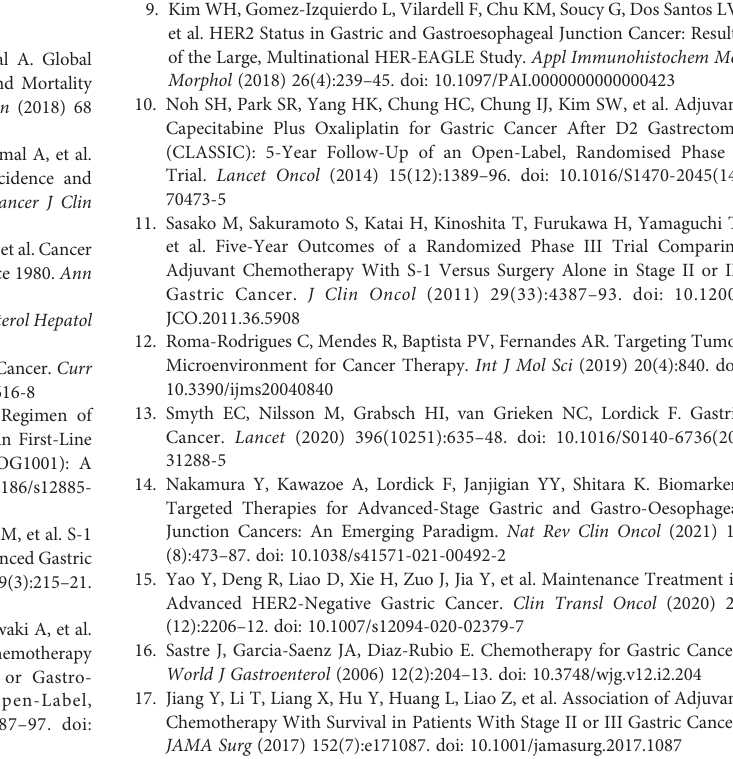
Supplementary Figure 1 | Data quality evaluation. (A) Box plot of protein identi fi cationnumbersin fi vehospitals. (B) PCAof833samplesin fi vehospitals. (C) Violin plotofproteinidenti fi cationnumbersinthreedatasets. (D) Boxplotofproteinabundance in each sample in three datasets. Supplementary Figure 2 | The clustering result and differentially expressed proteins of the molecular subtypes in discovery set. (A) The silhouette plot of clustering results obtained from AE. (B) Volcano plot of differentially expressed proteins in two subtypes. Supplementary Figure 3 | Classi fi ers were established to predict survival-risk labels for samples in independent set. (A) A heat map based on the 56 selected proteins expression. (B, C) The ROC curve of LR and SVM on training set with 10- fold CV, respectively. (D – F) The OS by chemotherapy status for S-II predict by RF, LR, and SVM, respectively. Supplementary Figure 4 | The clustering results obtained from two alternative approaches in discovery set. (A) The silhouette plot of clustering results and (B) the OS by chemotherapy status for S-II obtained from PCA. (C) The silhouette plot of clustering results and (D) the OS by chemotherapy status for S-II obtained from UMAP. Supplementary Figure 5 | The clustering results obtained by the protein features transformed from AE in the external validation set. (A) The silhouette plot of clustering results in DGC. (B, C) The clustering results for UFT-treated and (D, E) PacUFT-treated patients in the external validation